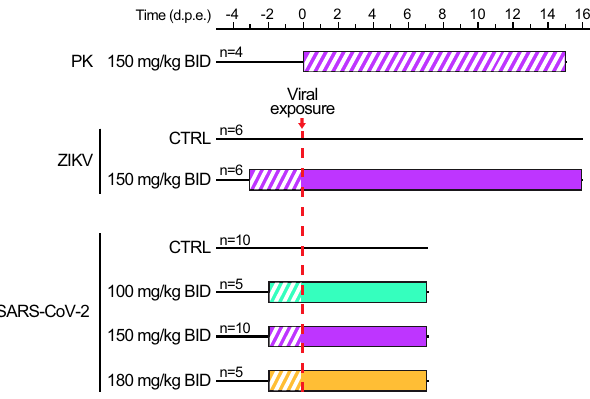
Fig. 1 | Study design of the 3 experiments. In the fi rst experiment of pharmaco- kinetic (PK), n =4 animals were treated with favipiravir (FPV) for 14 days. In the second experiment, n =12 were either treated or received placebo, and were challengedwith10 6 PFUofZikavirus(ZIKV)threedaysaftertreatmentinitiation.In thethirdexperiment, n =30animalswereeithertreatedorreceivedaplacebo,and were challenged with 10 6 PFU of SARS-CoV-2 two days after treatment initiation. Hatched area indicates FPV treatment without viral exposure. Colored areas indi- cate FPV dosing regimens; cyan: 200mg/kg twice a day (BID) administered intra- venously (i.v) on day − 2 followed by 100mg/kg BID administered subcutaneously (s.c); magenta:250mg/kg BID i.v.onday − 3(ZIKV)or − 2 (SARS-CoV-2)followed by 150mg/kgBIDs.c.;yellow:250mg/kgBIDi.v.onday − 2followedby180mg/kgBID sc. Untreated animals received NaCl 0.9% solution as placebo.